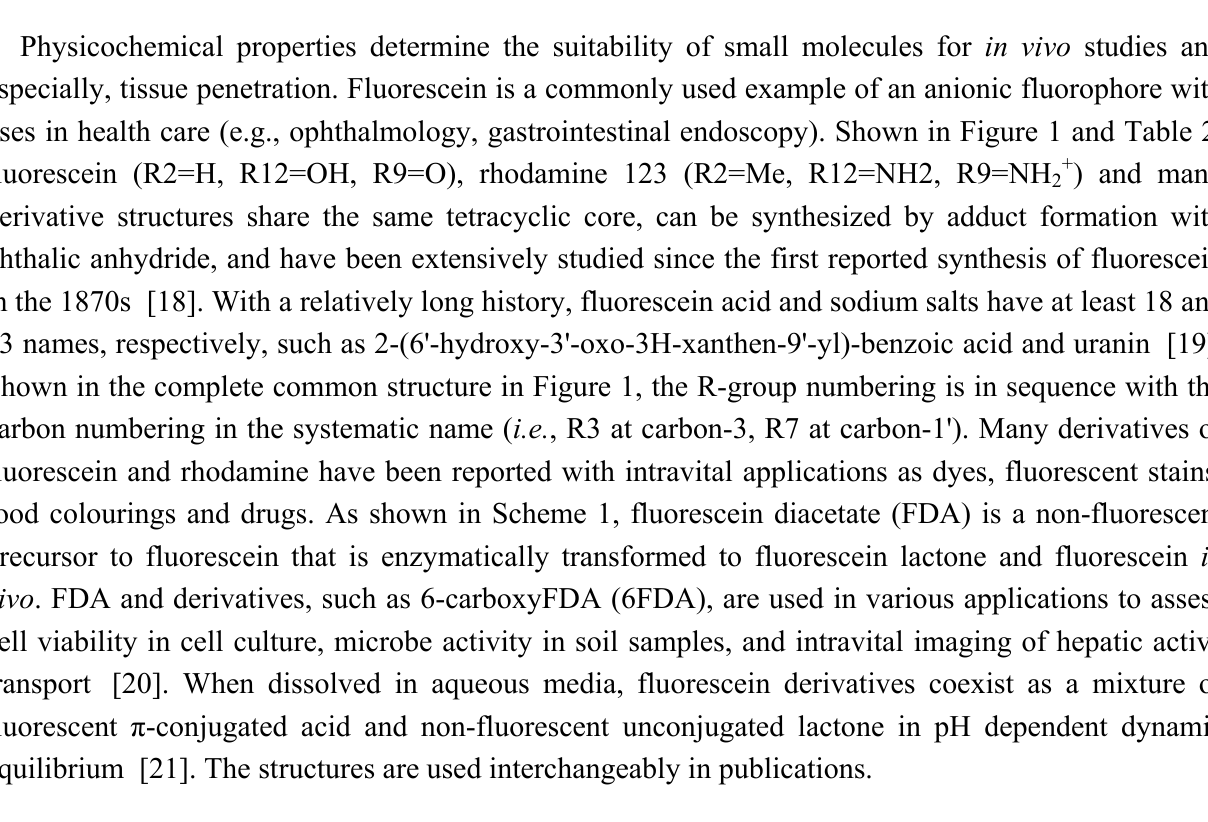
Figure 1. Common structures beside the structures of fluorescein, rhodamine, eosin Y and sulforhodamine